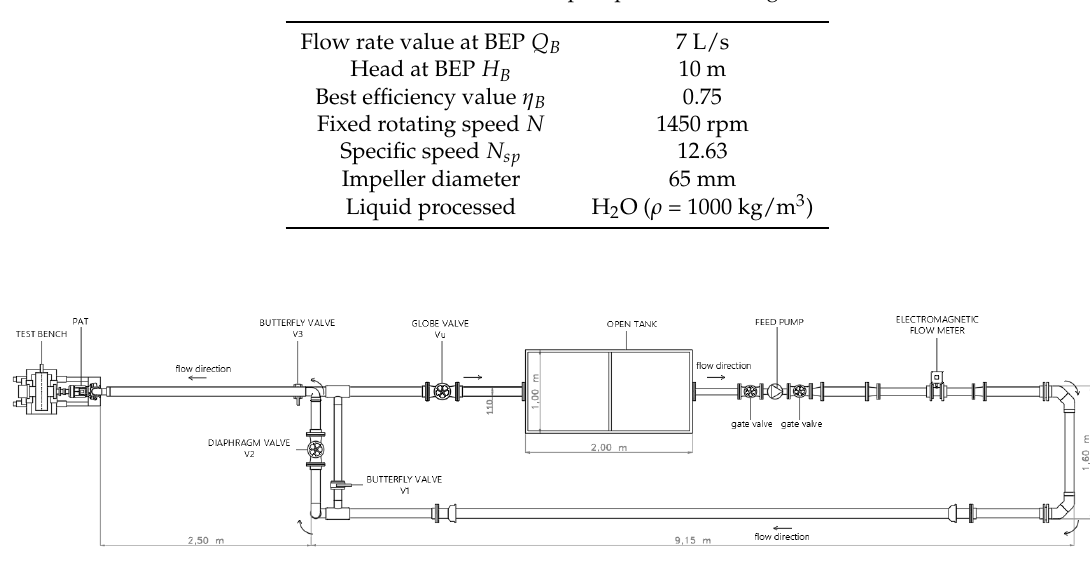
Table 1. Main characteristics of the Rotos pump when working in classical mode.